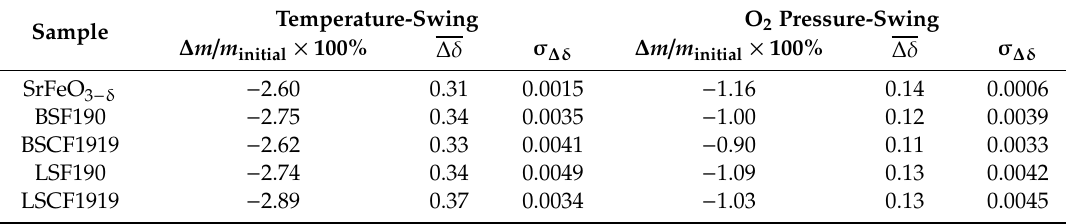
Table 4. Relative mass change and mean and standard deviation of deviation from stoichiometry change for A- and B-site substitutions in SrFeO 3−δ for TGA Screening 3 during the temperature- and O 2 pressure-swings.